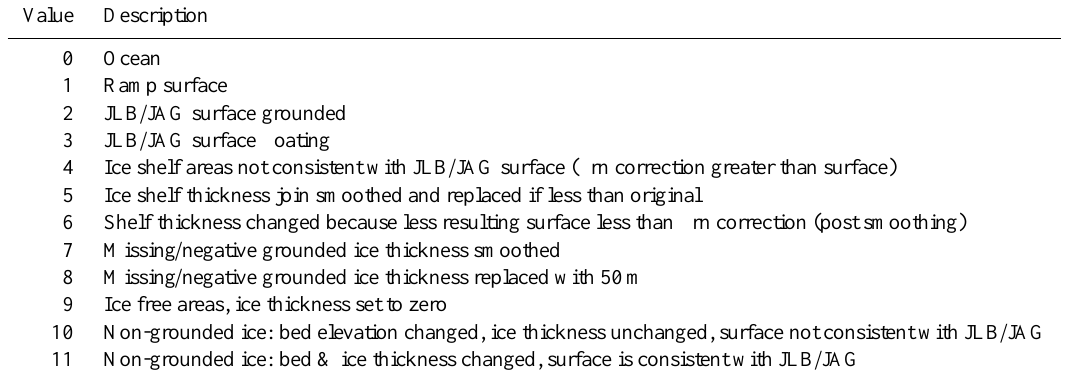
Table 5. Summary of umask